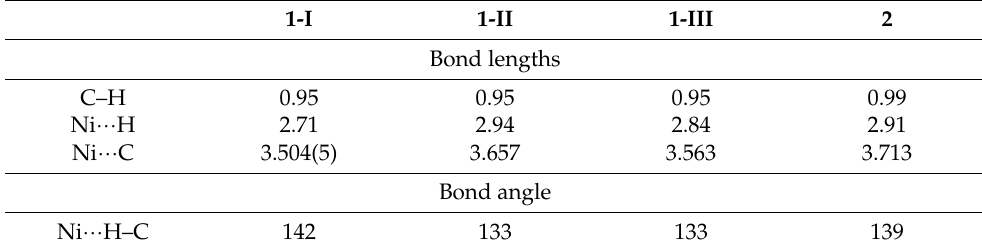
Figure 3. A trimer, formed by the C–H ··· Ni anagostic bonds between molecules 1-III ( left ), 1-II ( middle ), and 1-I ( right ) in the crystal structure of 1 (ellipsoids are drawn with 40% probability; CH hydrogen atoms, not involved in the anagostic interaction, are omitted for clarity). Color code: C = gold, H = black, N = blue, O = red, S = yellow, Ni = green; C–H ··· Ni anagostic interaction = cyan dashed line. Table 4. Bond Lengths (Å) and Angles (°) for 1 and 2 .